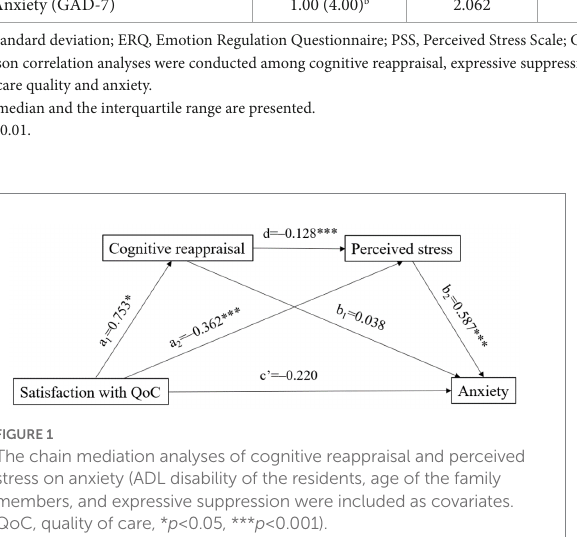
TABLE 3 Mediating model examination by bootstrap.